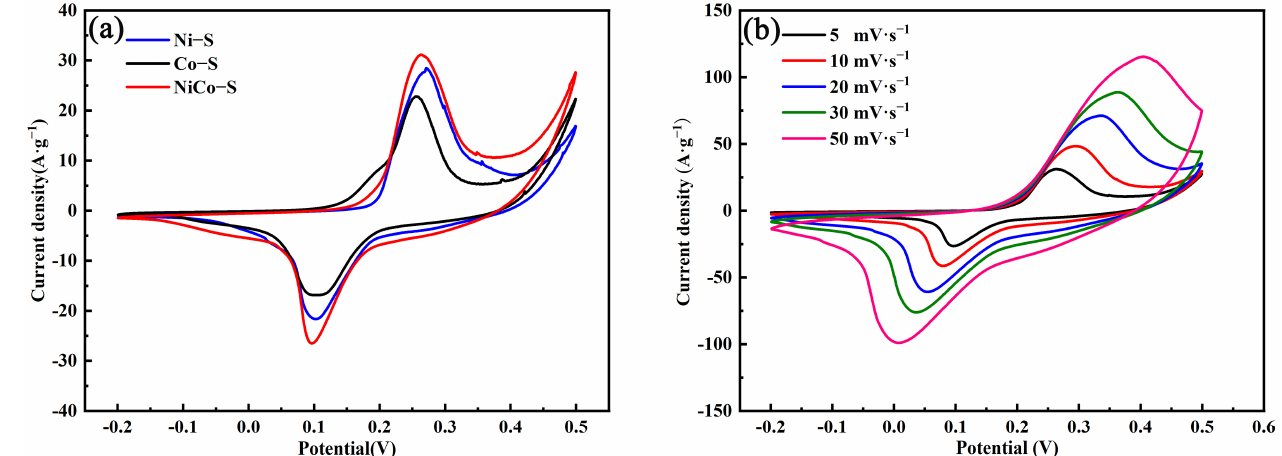
Figure 6. ( a ) CV curves of the prepared samples for Ni-S, Co-S, and NiCo-S at a scan rate of 10 mV·s − 1 . ( b ) CV curves at di ff erent scan rates of NiCo-S.